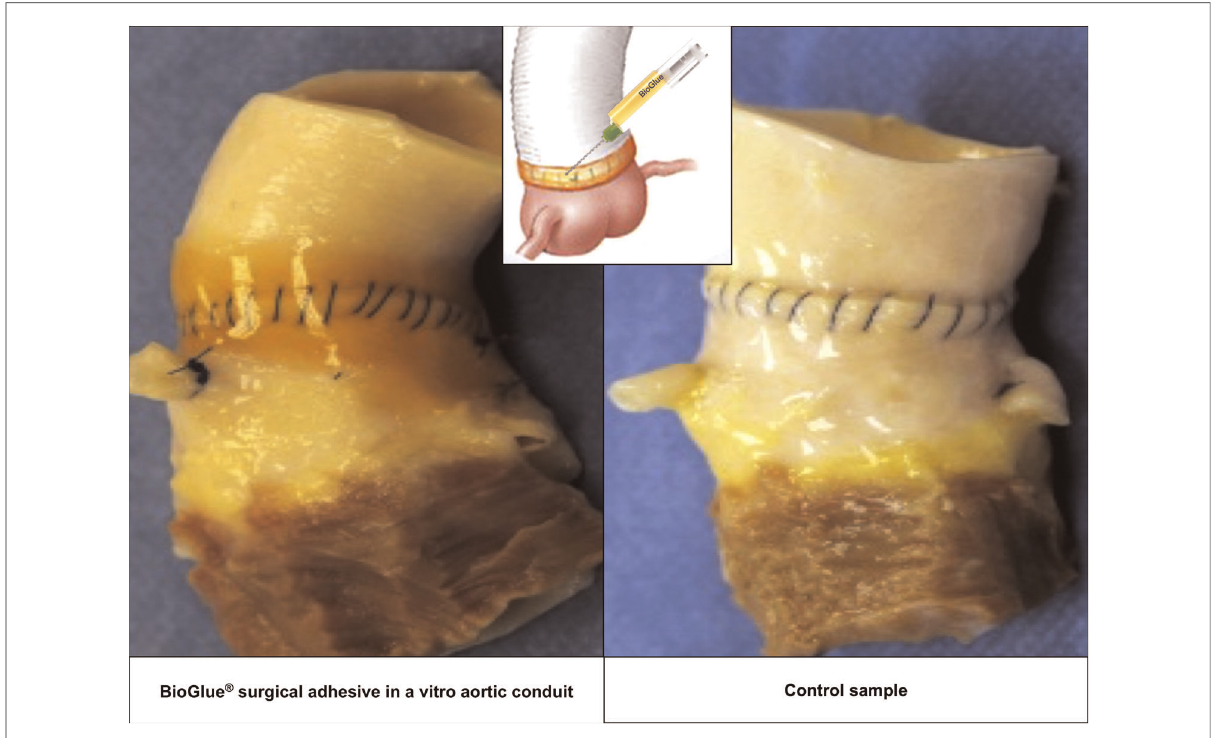
FIGURE 4 Aortic conduits in the BioGlue ® group (left) and the control group